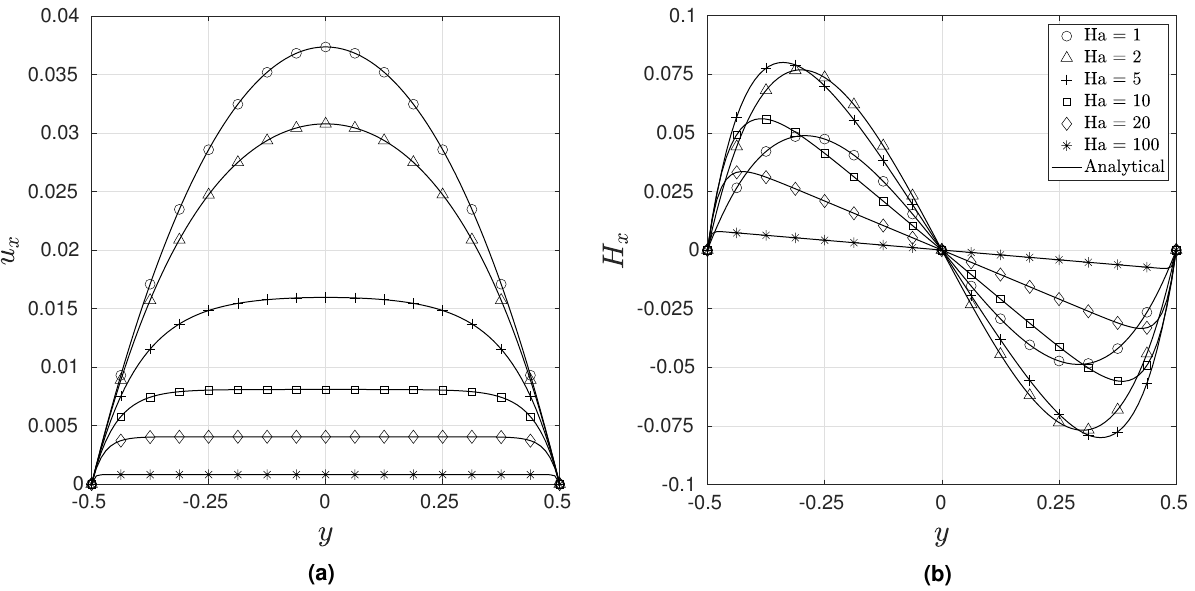
Figure 5. Comparison of the numerical and analytical solutions along the mid plane x = 0.5 m for Hartman–Poiseuille flow: ( a ) u x ( b ) H x